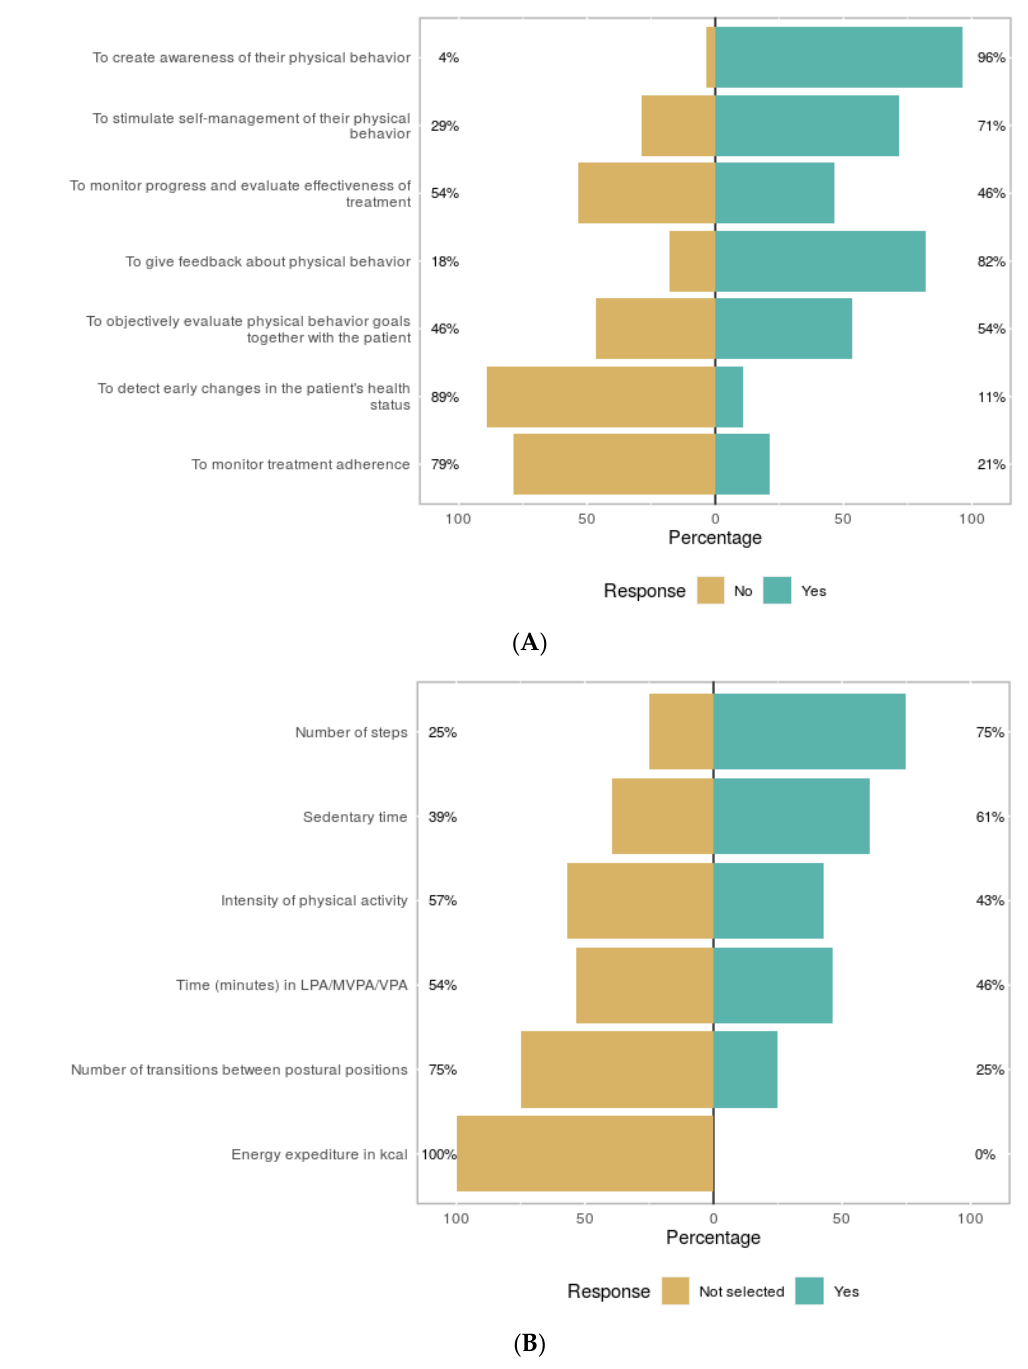
Figure 2. Treatment purposes ( A ) evaluated by users and outcome of interest of users ( B ). LPA= low physical activity, MVPA = moderate to vigorous physical activity, VPA = vigorous physical activity.